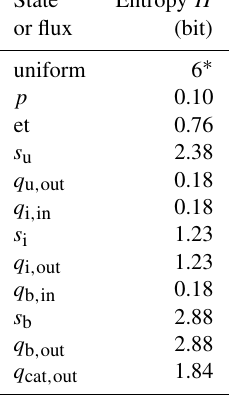
Table 3. Mean entropy of all normalised and binned SHM Attert states and fluxes of the reference run, for the period 1 Novem- ber 2011 00:00CET–31 October 2016 23:00CET. Please note that, hereafter, all times are given in Central European Time (CET). The states and fluxes are explained in Table